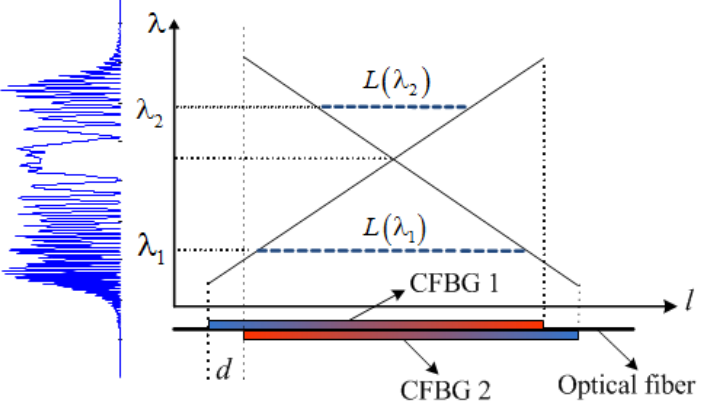
Figure 6. An optical spectral shaper consisting of two superimposed chirped fiber Bragg gratings with different chirp rates and a small longitudinal offset. The spectral shaper has a chirped spectral response thus can be used to generate chirped microwave waveforms based on DFT technique. CFBG: chirped fiber Bragg